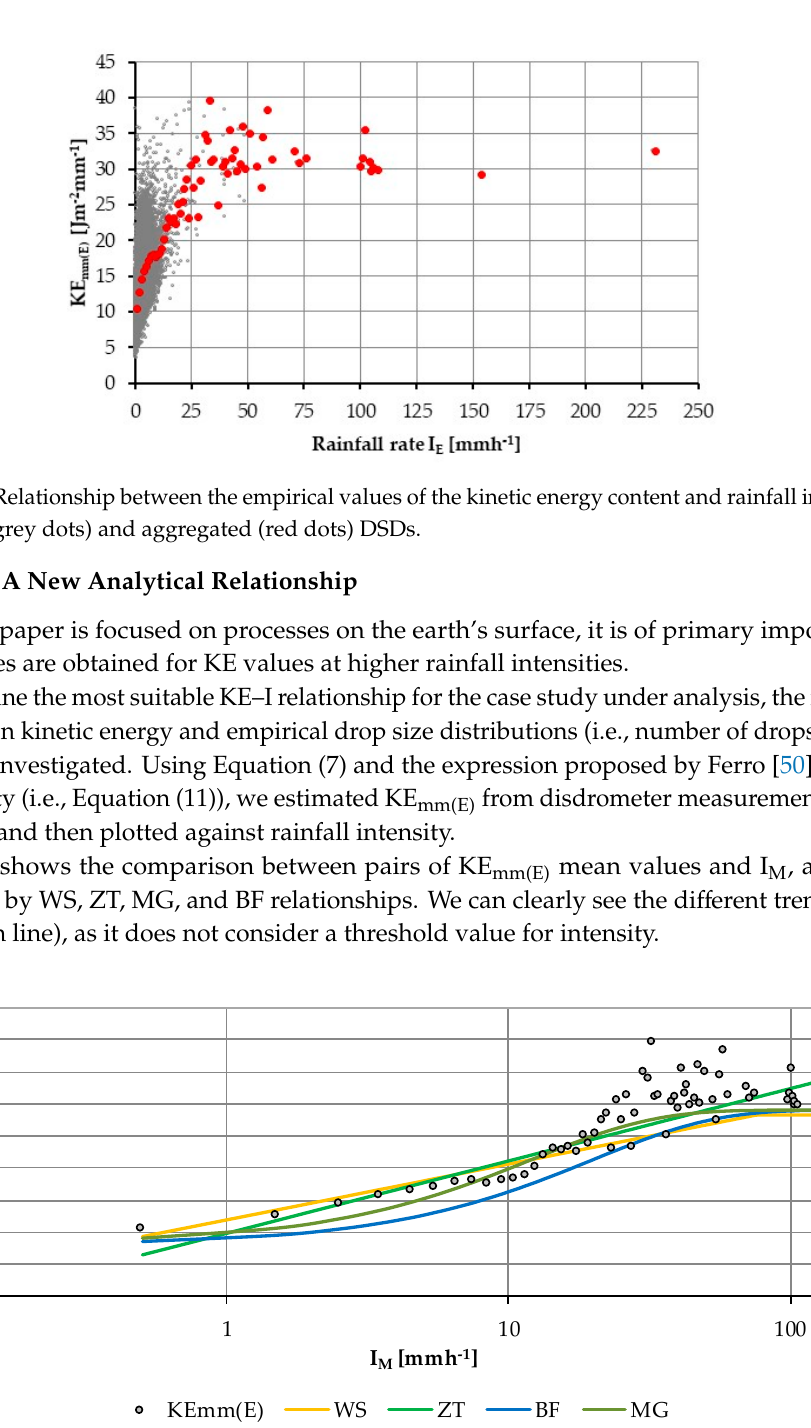
Figure 11. Relationship between the empirical values of the median volume diameter and rainfall intensity for single (grey dots) and aggregated (red dots) DSDs.